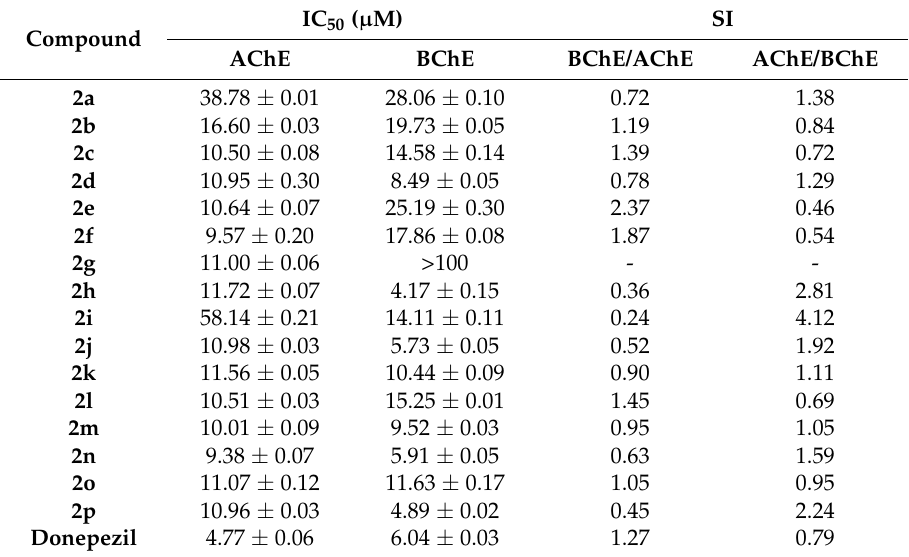
Table 2. AChE and BChE inhibitory activities of flavonols 2a – p